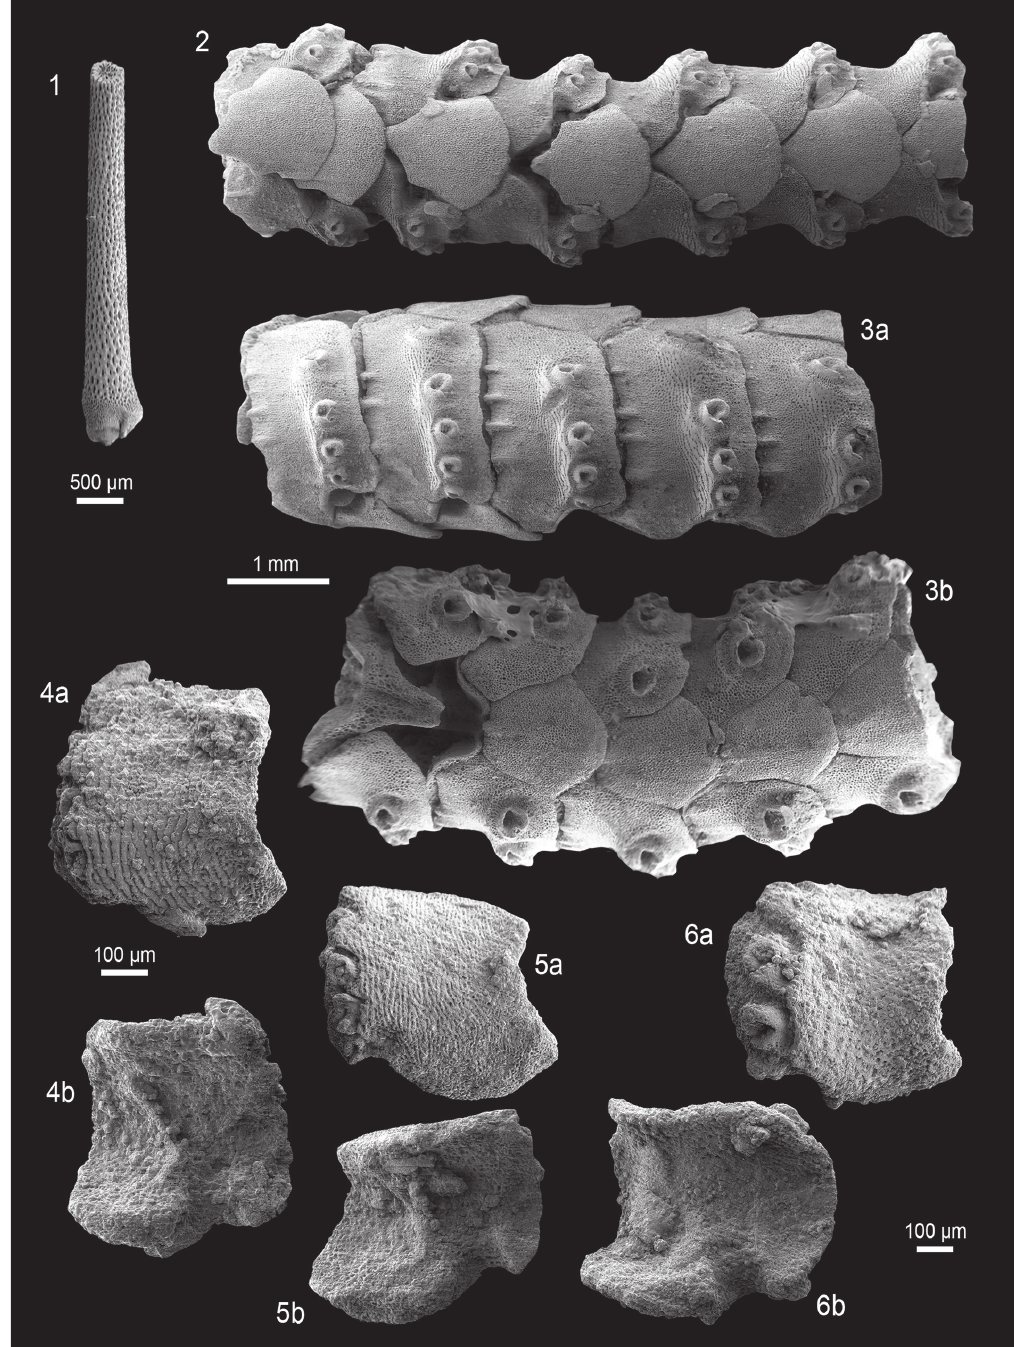
Fig. 25. Fossil skeletal plates and articulated arm fragments of ophiacanthid brittle stars; lateral arm plates (LAPs) in external (a) and internal (b) views. 1-3. Alternacantha dilionessa sp. nov. from the early Kimmeridgian of the Pointe du Chay, France. 1. GZG.INV.78666 (paratype), arm spine. 2. GZG. INV.78667 (paratype), median arm fragment in ventral view. 3. GZG.INV.78668 (paratype), proximal arm fragment in lateral (a) and dorsal (b) views. 4-5. Dermocoma subtilirugosa (Kristan-Tollmann & Gramann, 1992) comb. nov. from the Rhaetian (Late Triassic) of Fischerwiese, Austria. 4. GZG.INV.78671, proximal LAP. 5. GZG.INV.78672, median LAP. 6. Dermocoma sp. nov. innom. 1 from the Rhaetian (Late Triassic) of Fischerwiese, Austria; GZG.INV.78674, median LAP. One common scale bar per species except for